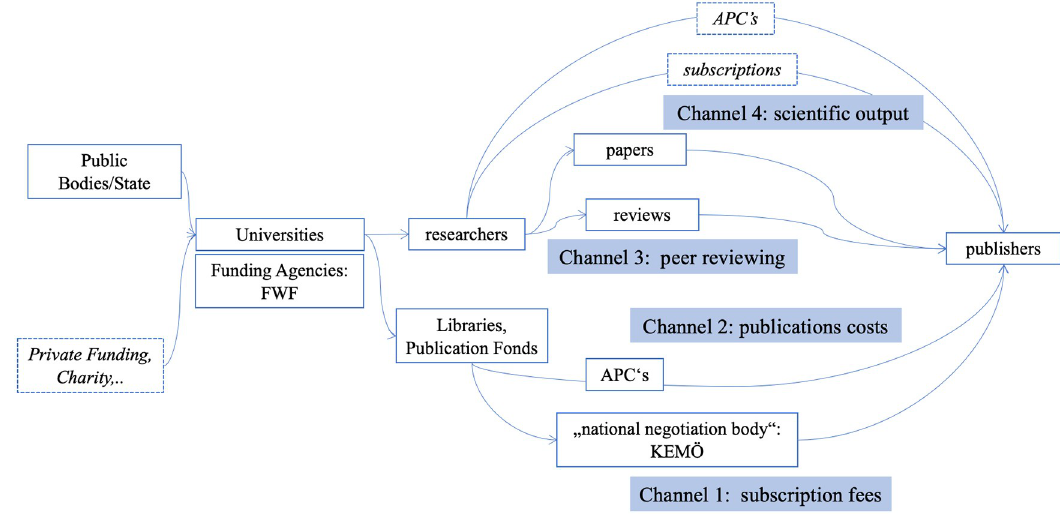
Fig 2. Four channels of access to public funding for academic publishers. This representation is based on